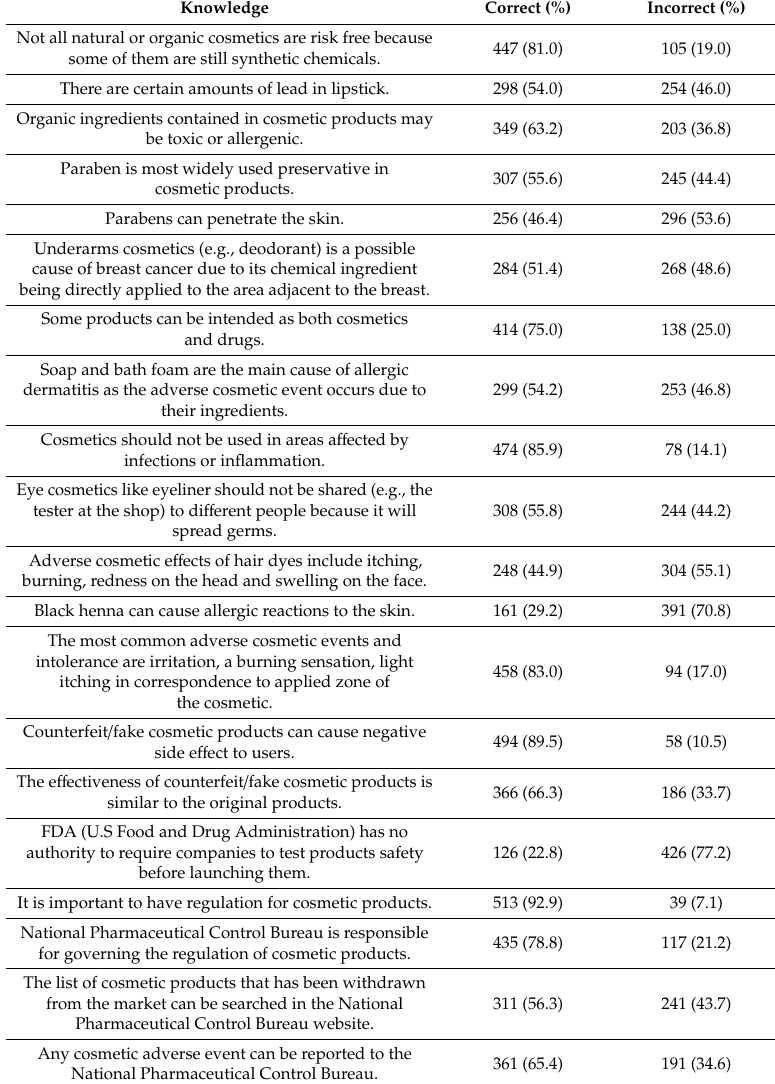
Table 3. Response of participants to the questions on knowledge of cosmetic